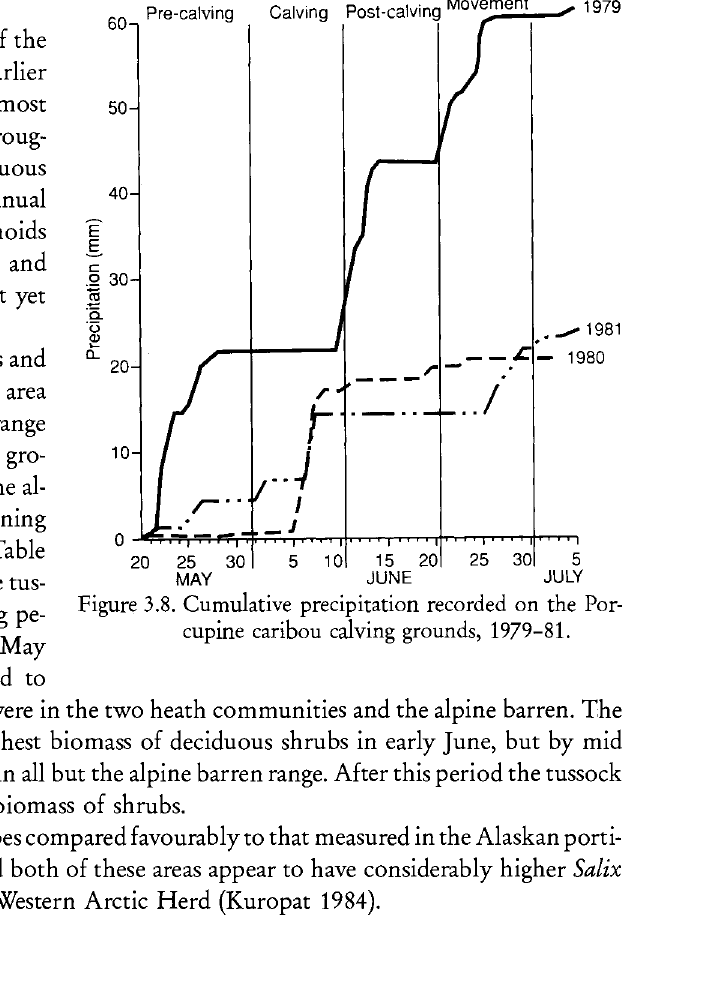
Table 3.1. New green biomass (g/m 2 ) on the Yukon calving grounds of the Porcupine Caribou Herd,